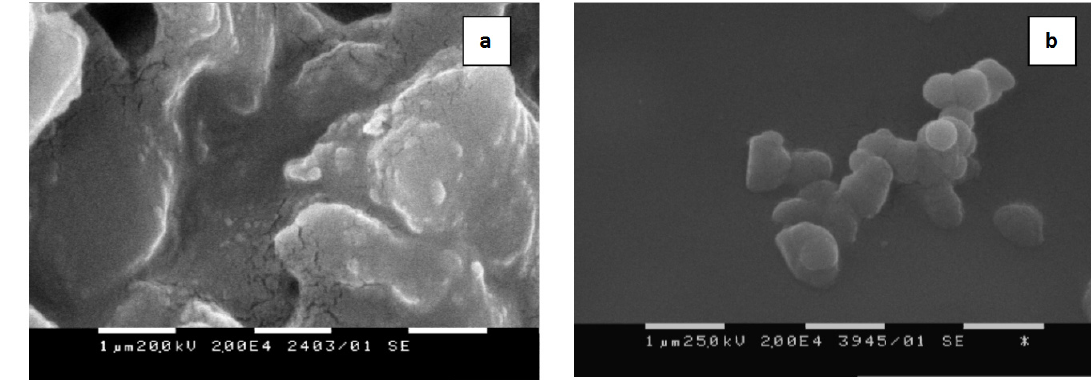
Figure 8. SEM of the PU/10BG (a) and PU/20BG (b) at ×20 000 after in vitro test for bioactivity for 7